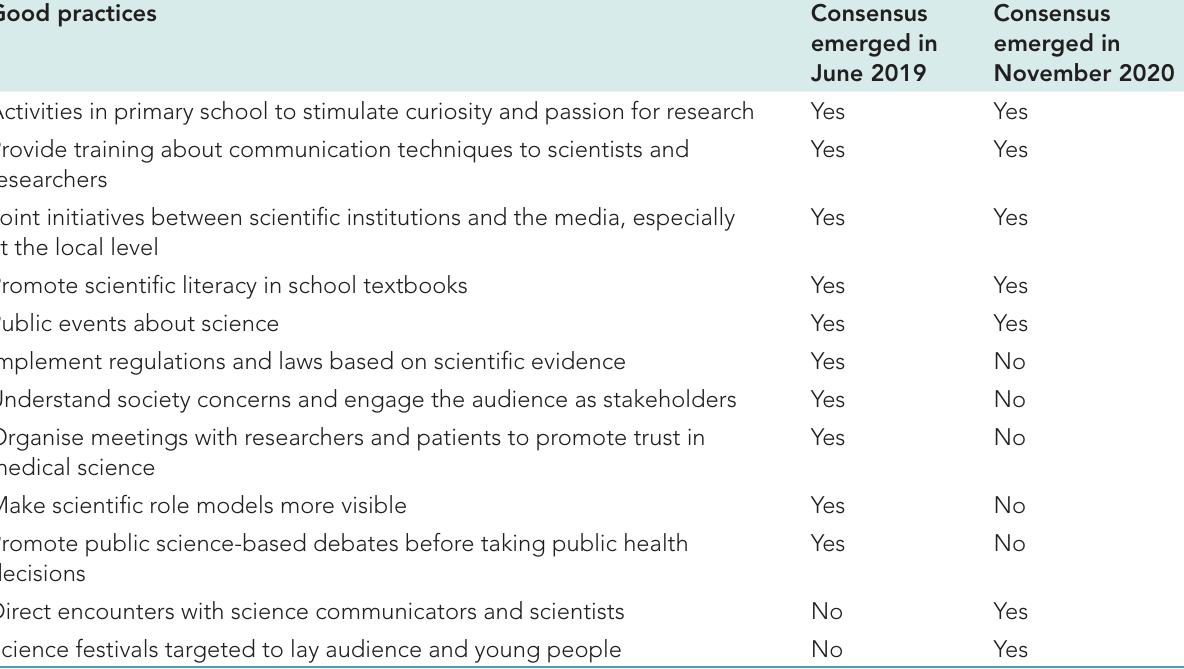
Table 5. Good practices to foster trust in scicomm proposed by the Delphi panel (Source: Authors, 2022) Good